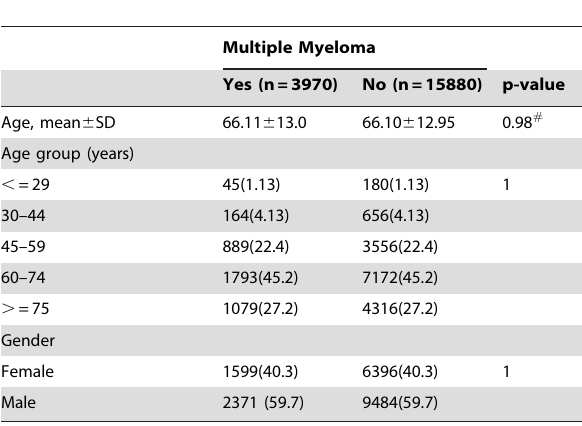
Table 1. Demographic characteristics of cohorts with and without multiple